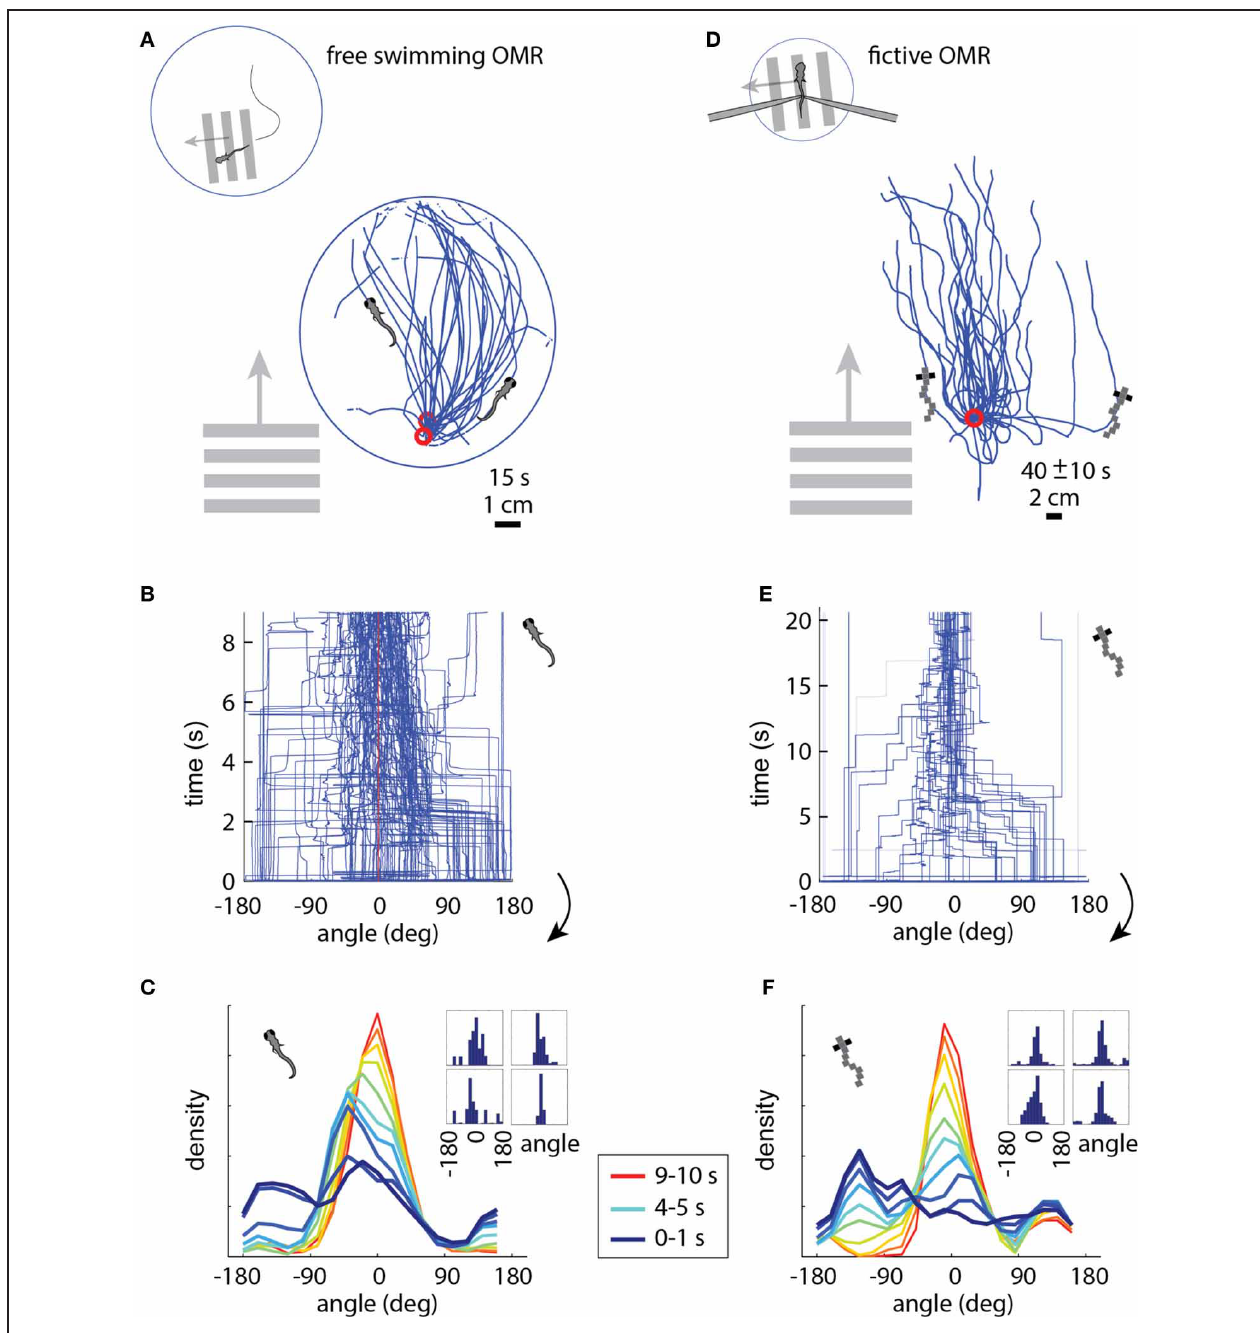
FIGURE 3 | The optomotor response in free (A–C) and paralyzed (D–F) fish. (A) Swim trajectories during visual whole-field motion projected at the bottom of a 10cm petri dish ( N = 3 example fish). Grating period was 1cm, speed 1cm/s. Data have been rotated so that the starting point is near the bottom of the dish, as seen from above. (B) Heading angle over time for N = 6 freely swimming fish. The time axis is cut off at 9s, because at that time a number of fish reached the end of the petri dish and the heading angle became ill-defined. (C) Changing heading direction over time; same data as (B) . Dark blue: histogram at start of trials ( N = 6 fish, 10 trials each). Red: histogram 10s after trial onset. Each color represents one second of data. Inset: Histograms of heading angle,